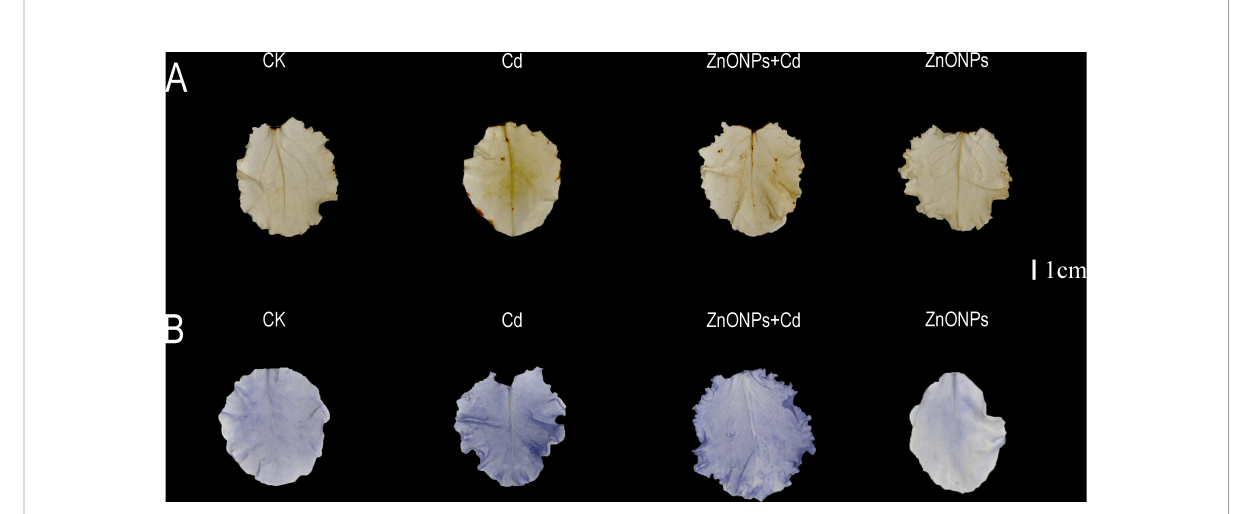
FIGURE 4 H 2 O 2 (A) and O 2- (B) detection of leaf diaminobenzidine and nitro blue tetrazolium staining. Bar= 1 cm. Brown and blue colors indicate the amount of H2O2 and O2- in lettuce leaves, and small amounts of brown and blue colors indicate less accumulation of H 2 O 2 and O 2- in the